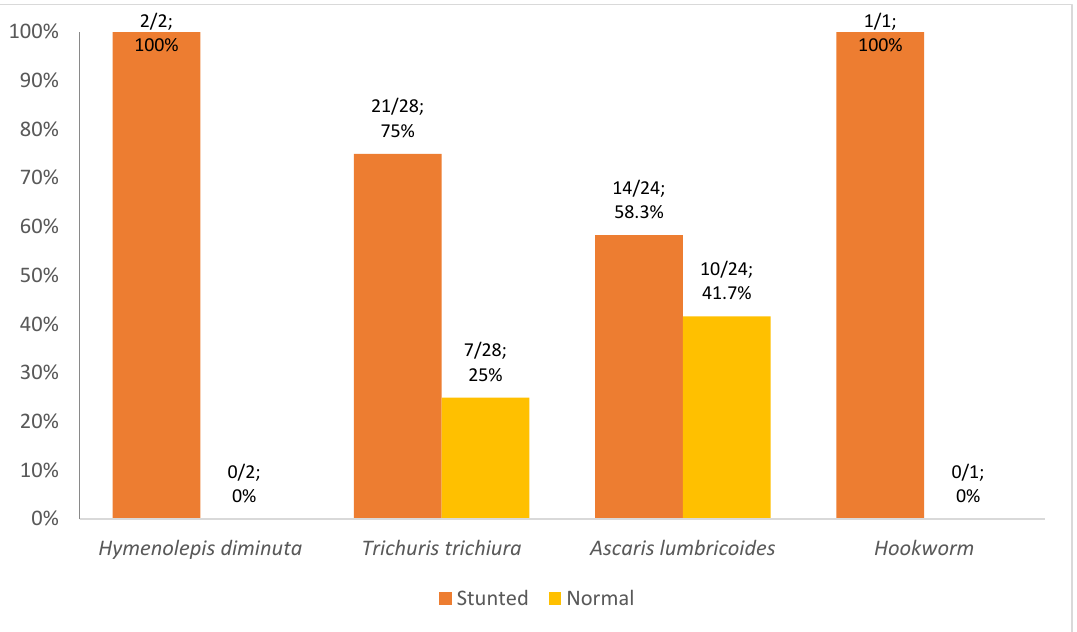
Figure 5. Type of helminthic in stunted and normal children in East Nusa Tenggara; n = 51 children. Hymenolepis diminuta was detected in a total of 2 children; Trichuris trichiura was detected in a total of 28 children; Ascaris lumbricoides was detected in a total of 24 children; Hookworm was detected in a total of 1 child (one child had ≥ 1 helminthic parasites).